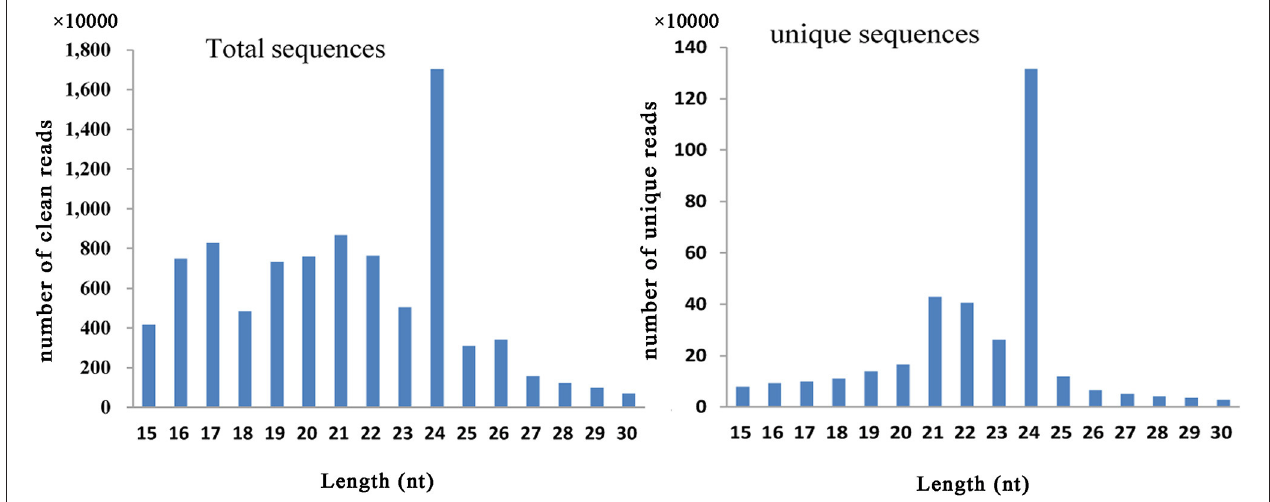
FIGURE 1 | Distribution of small RNAs among different categories in Lilium pumilum DC. Fisch.